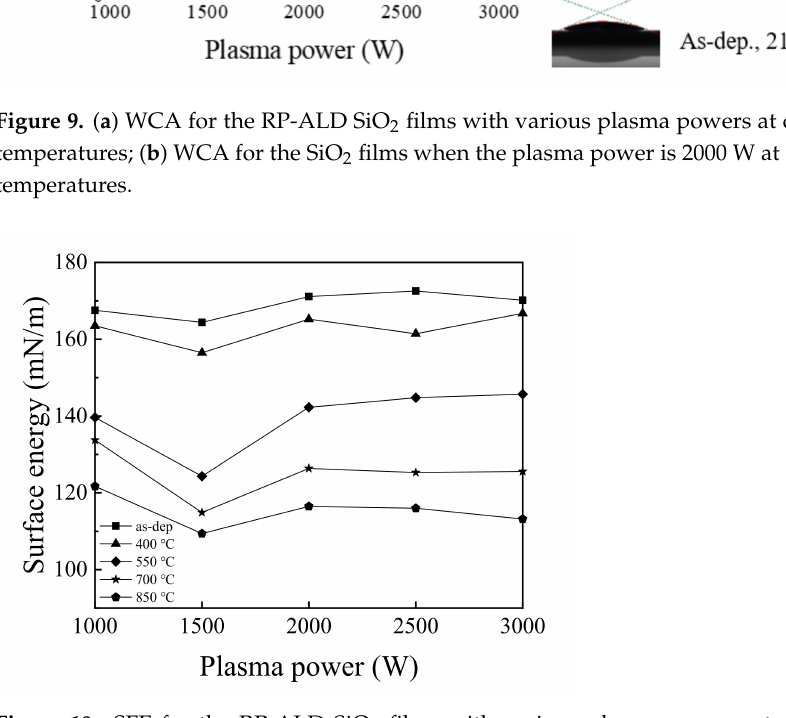
Figure 10. SFE for the RP-ALD SiO 2 films with various plasma powers at different annealing